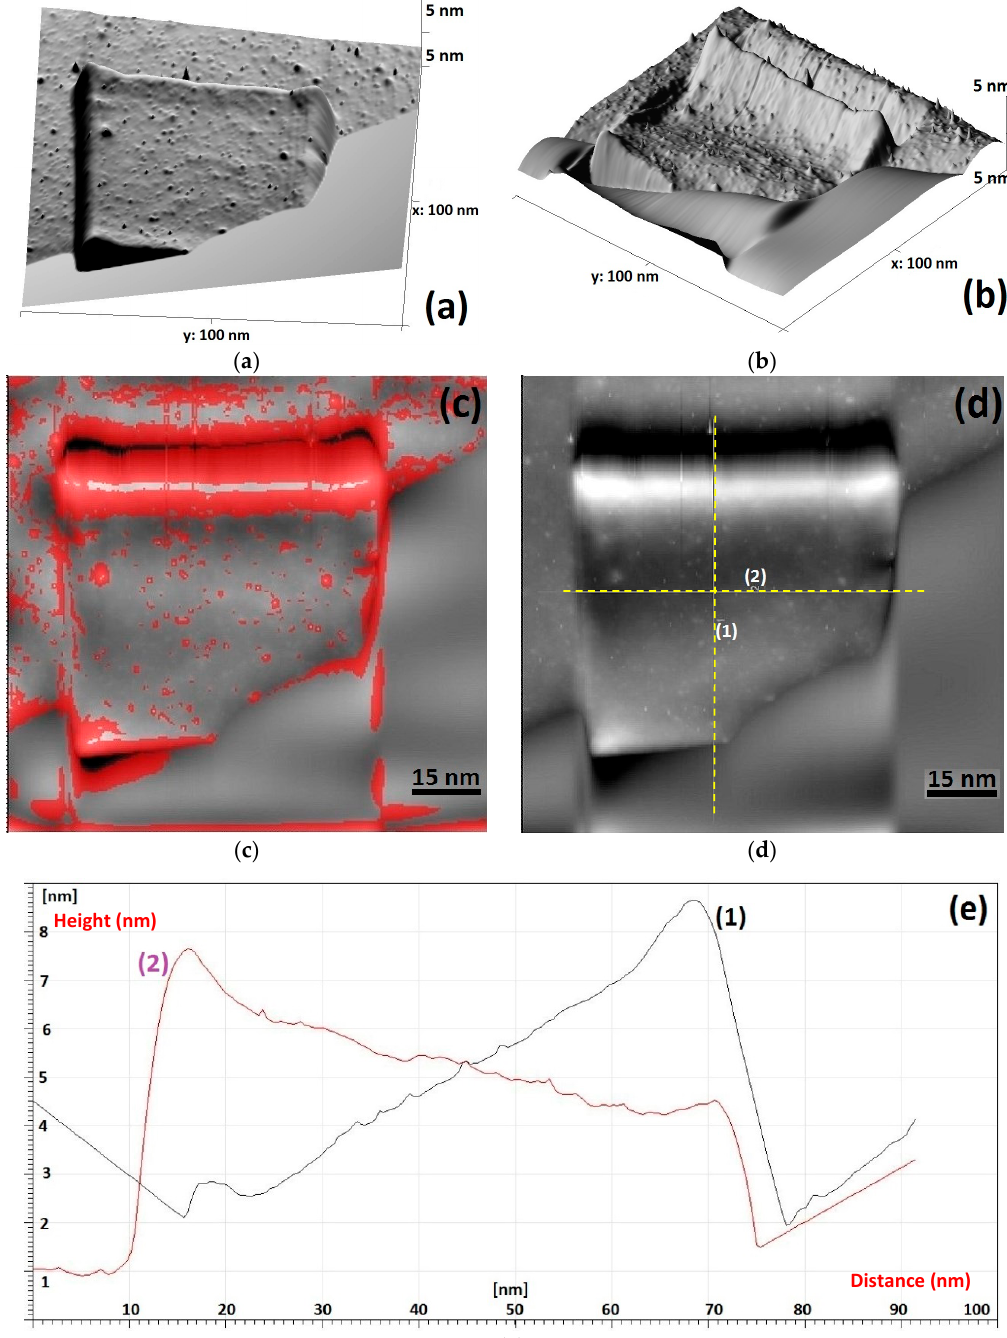
Figure 4. Selected surface area demonstrating the platelet shape precipitate, scanned by AFM using different channel modes; ( a ) height channel exposure, ( b ) frequency channel, ( c ) dissipation channel, ( d ) phase contrast micrograph, ( e ) line profiles corresponding to the surface roughness of the particle.